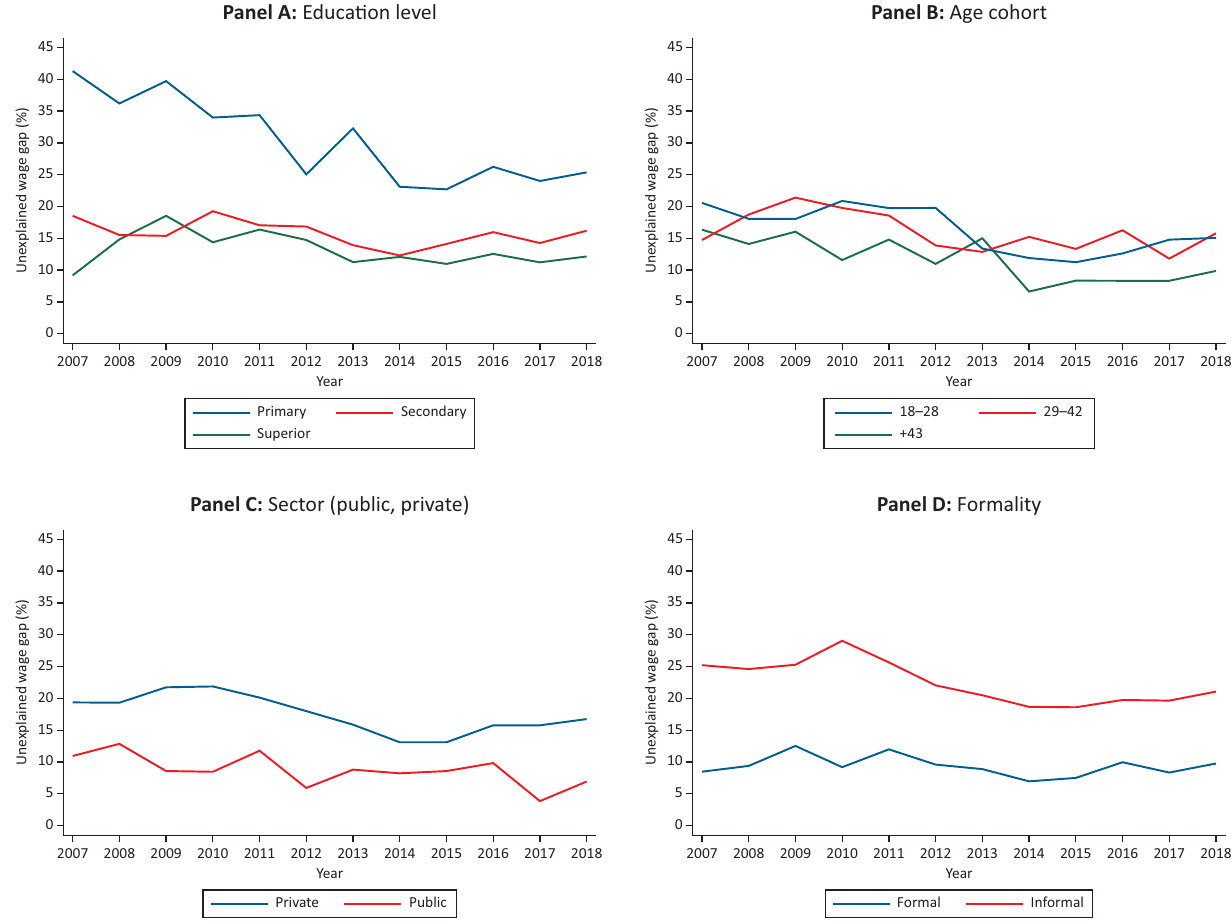
Figure 3. Unexplained wage gap across subgroups. Notes: All decompositions include controls such as education, native tongue, age, tenure, private sector and firm size, occupation, economic activity, and regional fixed